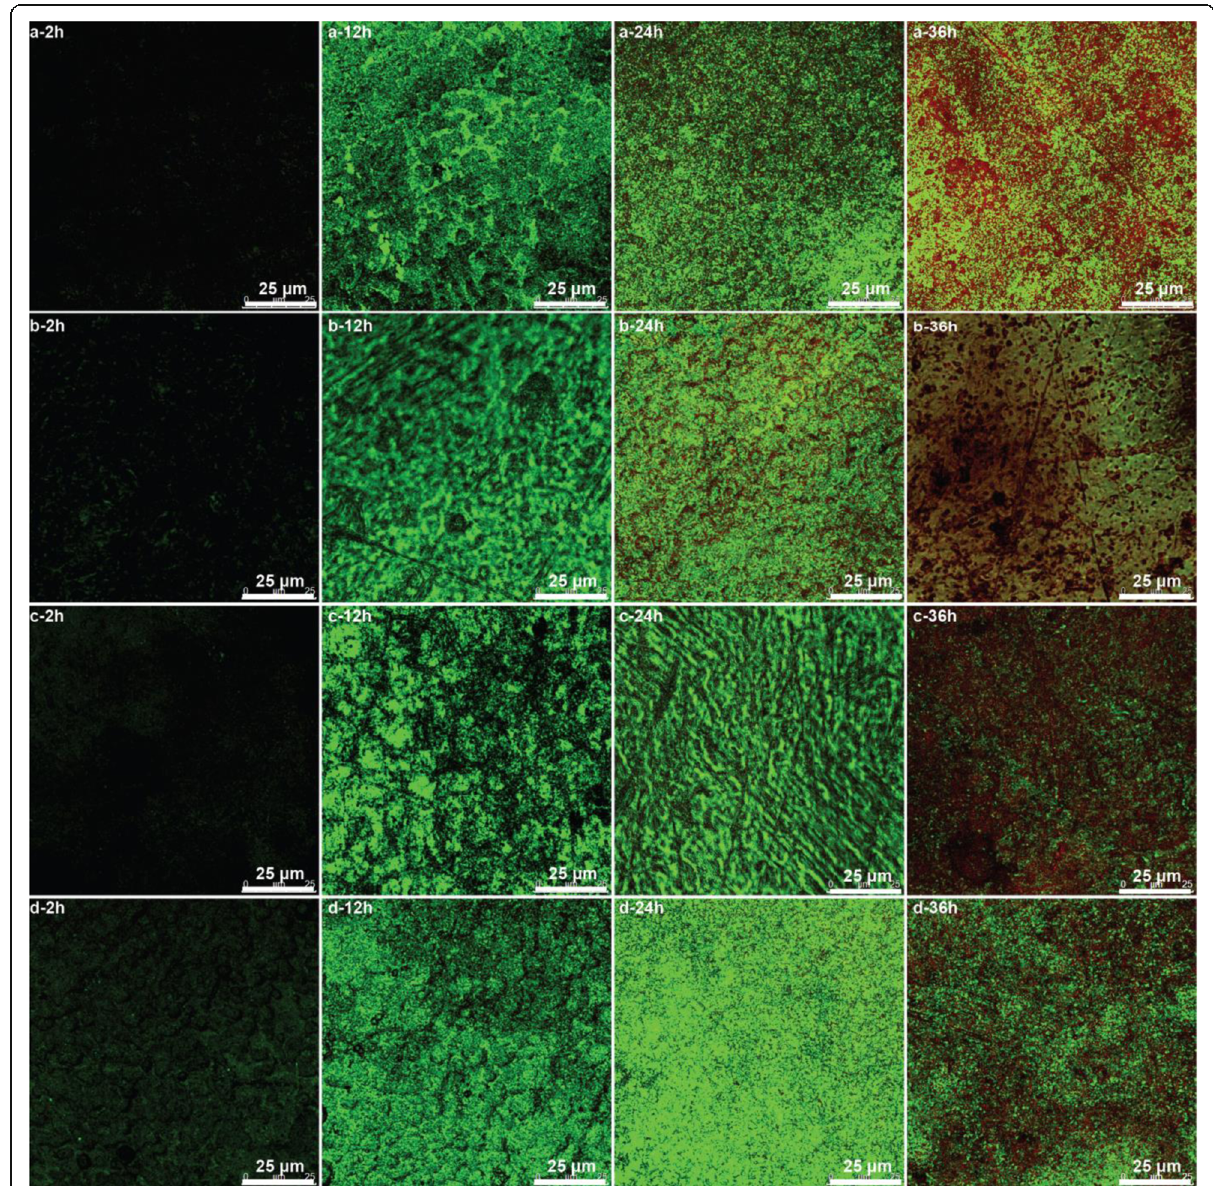
Fig. 9 CLSM images biofilms formed on the zinc oxide films prepared on PAA with different time of two-step anodization duration a 0 min, b 40 min, c 60 min, and d 80